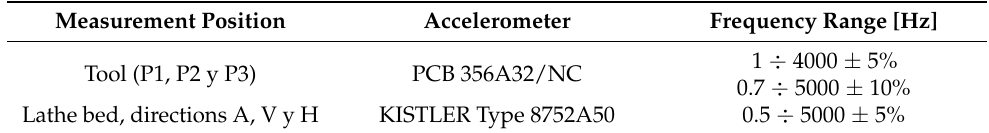
Figure 1. Triaxial accelerometers installed in the tool: ( a ) frontal view; ( b ) rear view. Table 2. Accelerometers used for the measurements.